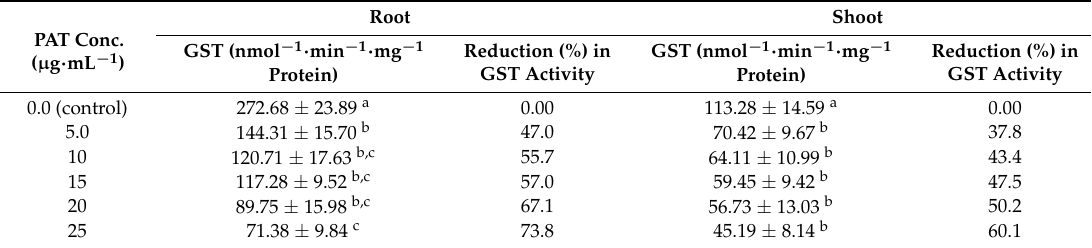
Table 1. Effect of different concentrations of PAT on the GST activity of root and shoot of 8-day-old maize seedlings.